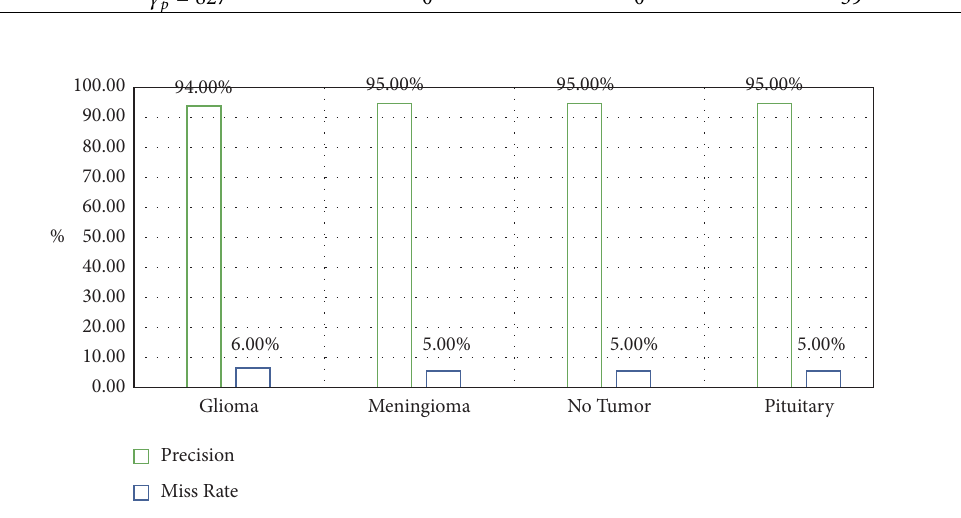
Figure 2: Performance of the proposed HDL2B-TUMOR-CLASSIFIER (training). Table 3: Decision matrix for HDL2B-TUMOR-CLASSIFIER (validation).